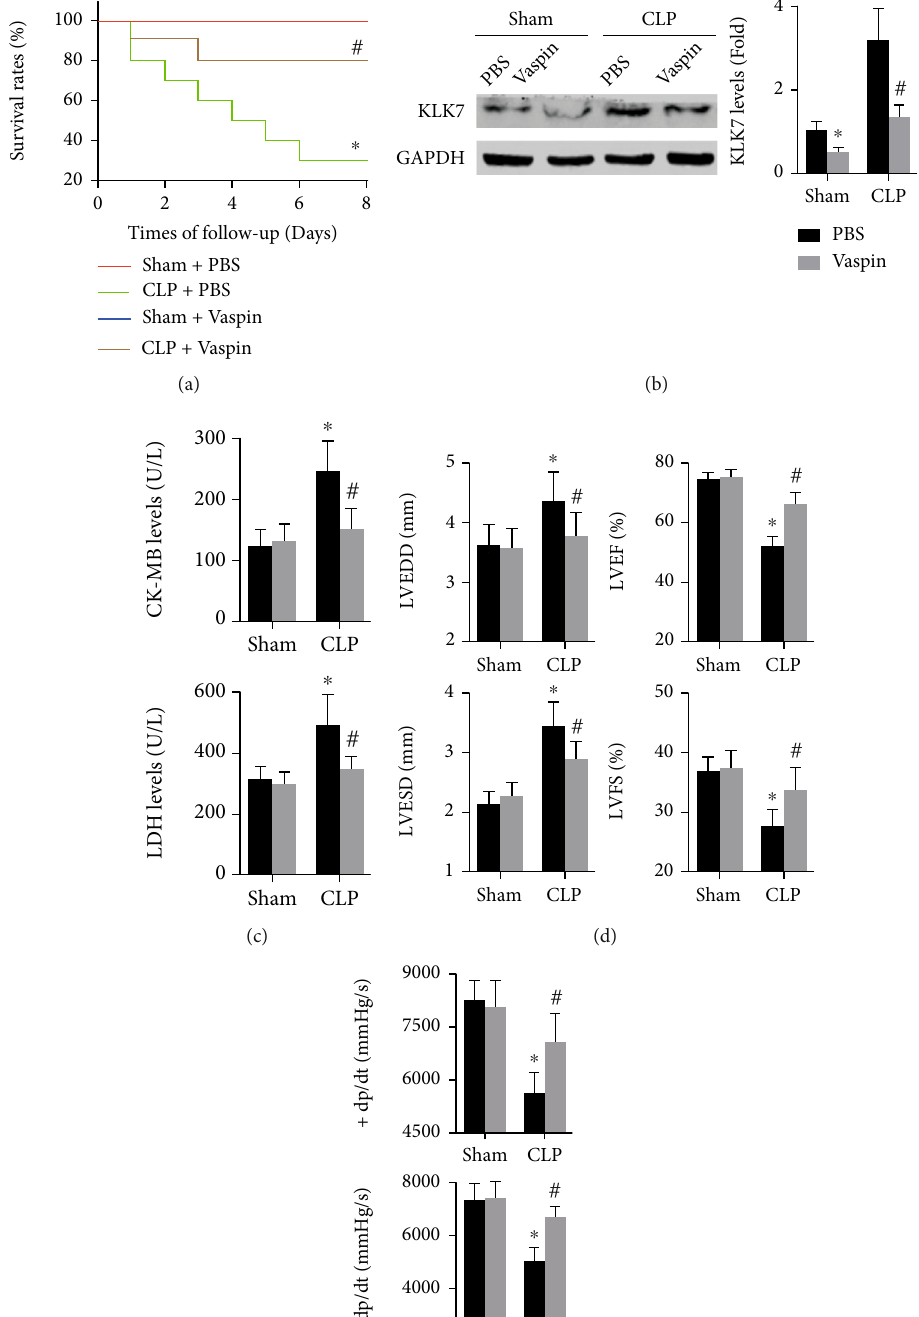
Figure 3: E ff ects of vaspin on survival rates and cardiac dysfunction in CLP mice. (a) The survival rates in each group were examined during the 8-day follow-up (log-rank test). (b) Cardiac KLK7 expression in the four groups was measured (two-way ANOVA). (c) Serum levels of CK-MB and LDH in all groups were analyzed (two-way ANOVA). (d, e) Cardiac structural and functional data were examined, including LVEDD, LVESD, LVEF, FS, +dp/dt max, and -dp/dt max (two-way ANOVA). N = 5 − 10 in each group. ∗ p < 0 : 05 vs. the sham + PBS group. # p < 0 : 05 vs. the CLP + PBS